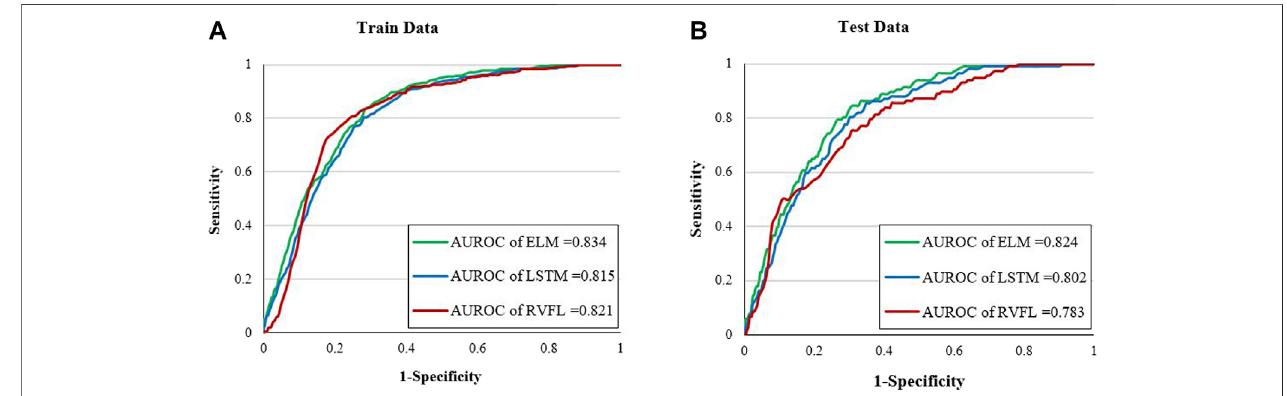
Frontiers in Environmental Science |